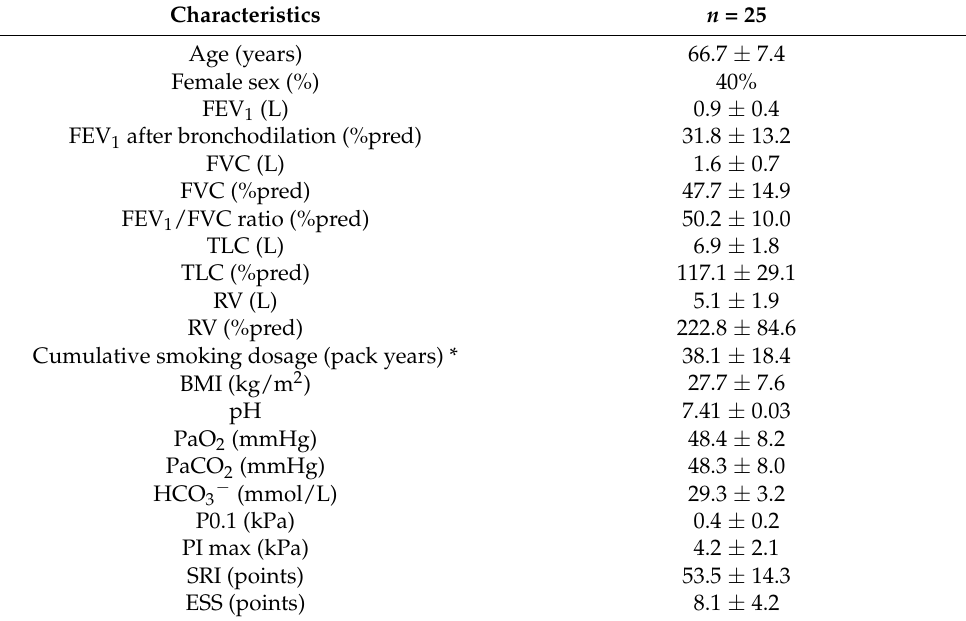
Table 1. Patient characteristics at